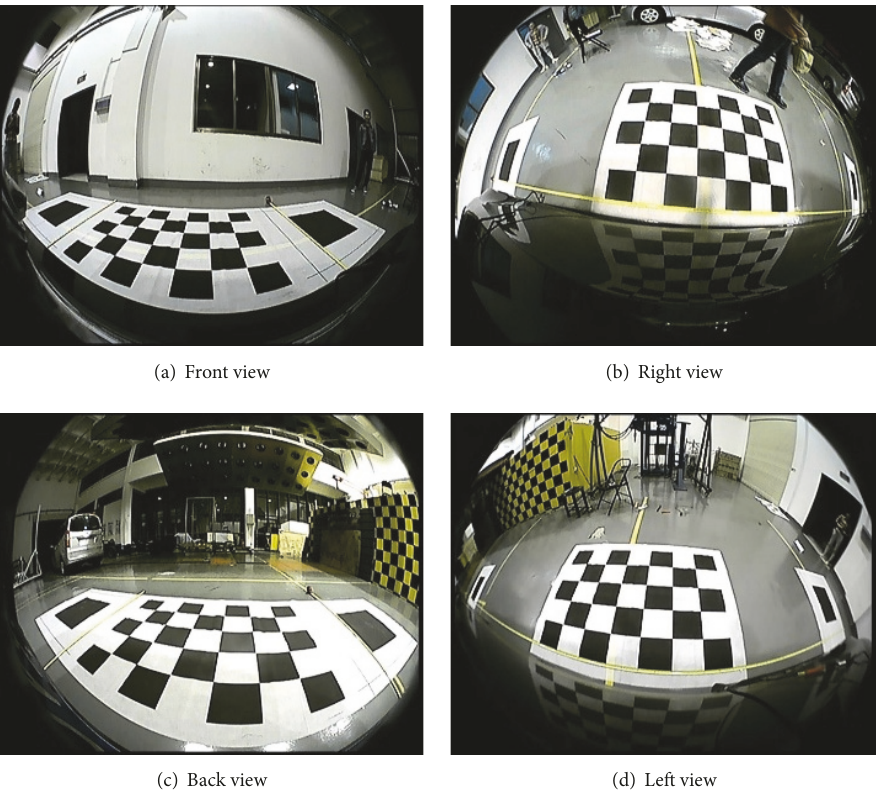
Figure 6: Fisheye images from each camera.